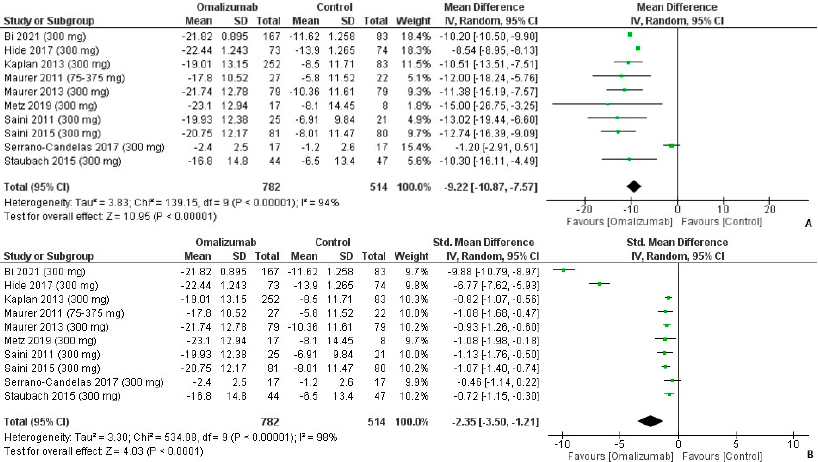
Figure 10. UAS7 outcomes with 300 mg dosage of omalizumab [17–26]. ( A ): Mean difference: − 9.92 [95% CI: − 10.87, − 7.57]; Heterogeneity: Tau² = 3.83; Chi² = 139.15, df = 9 ( p < 0.00001); I² = 94%; Test for overall effect: Z = 10.95 ( p < 0.00001). ( B ): Standardized mean difference: − 2.35 [95% CI: − 3.50, − 1.21]; Heterogeneity: Tau² = 3.30; Chi² = 534.08, df = 9 ( p < 0.00001); I² = 98%; Test for overall effect: Z = 4.03 ( p < 0.0001).